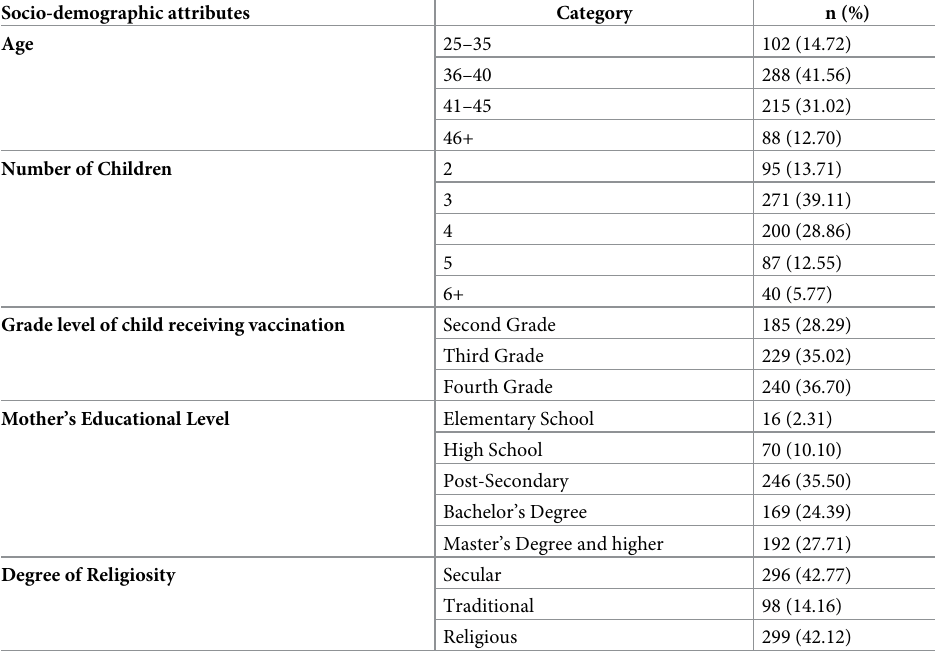
Table 1. Socio-demographic characteristics of Jewish and Arab mothers (n =